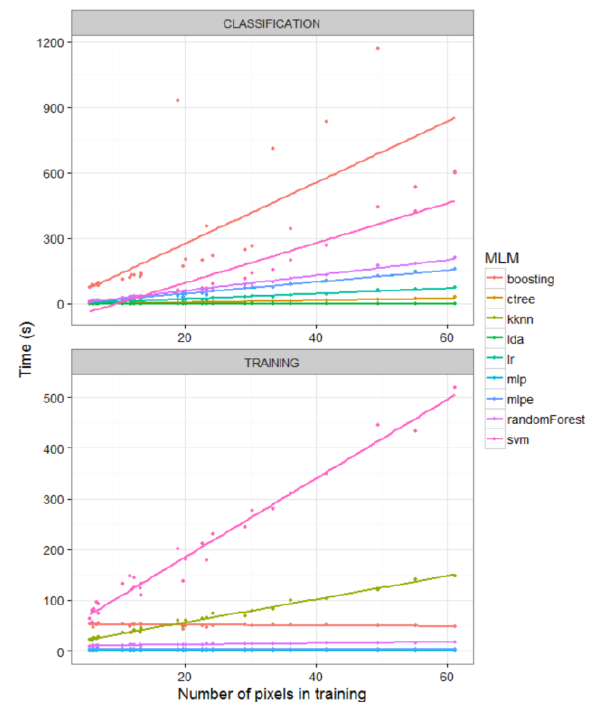
Figure 4. Benchmark results of processing speeds for each MLM with different number of pixels used in the training phase.